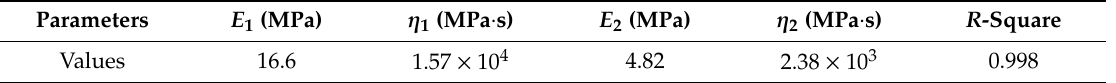
Table 3. Viscoelastic parameter values for the control sample.